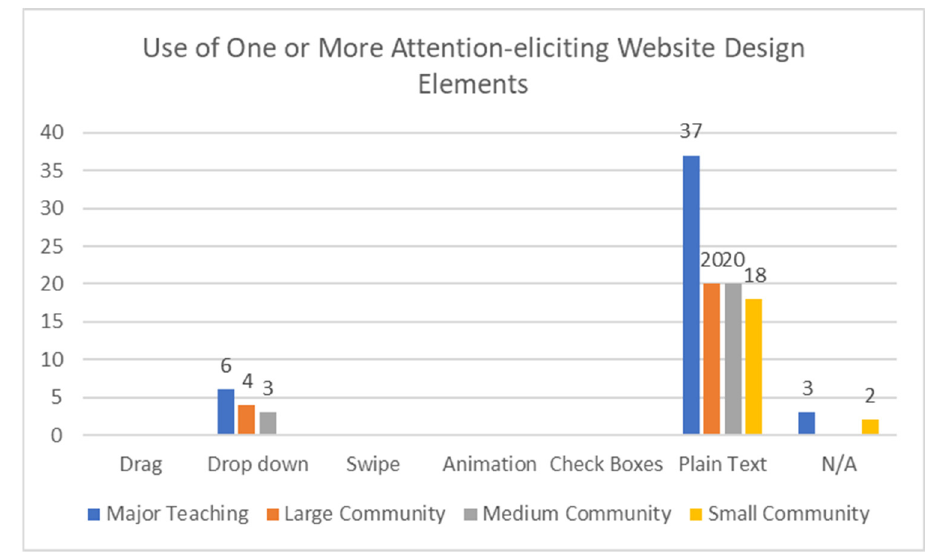
Figure 7. Use of Attention-eliciting Website Design Elements.